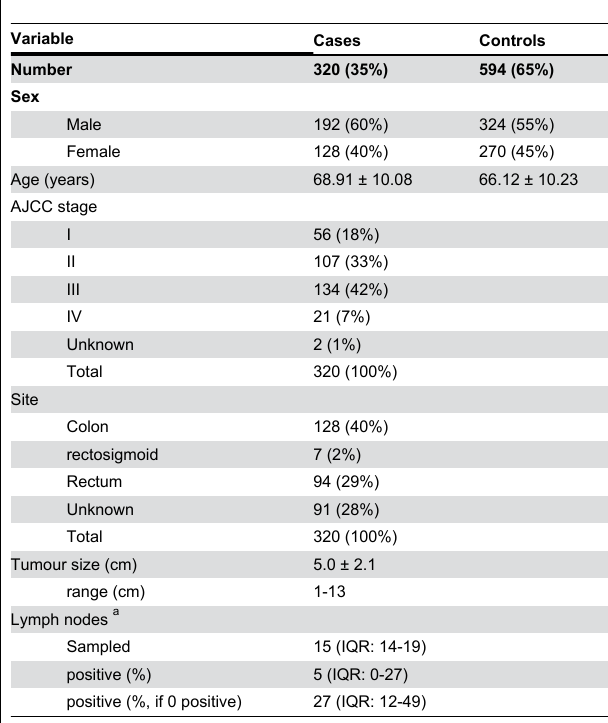
Table 1. Characteristics of study